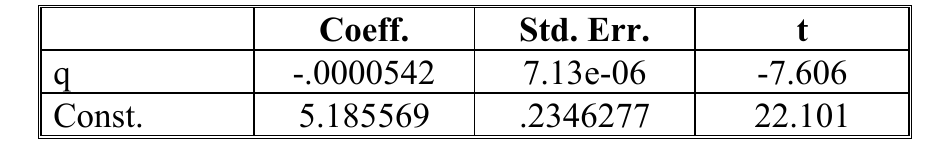
Results of estimating a constrained linear demand function for tourists from African countries Coeff. Std. Err. q